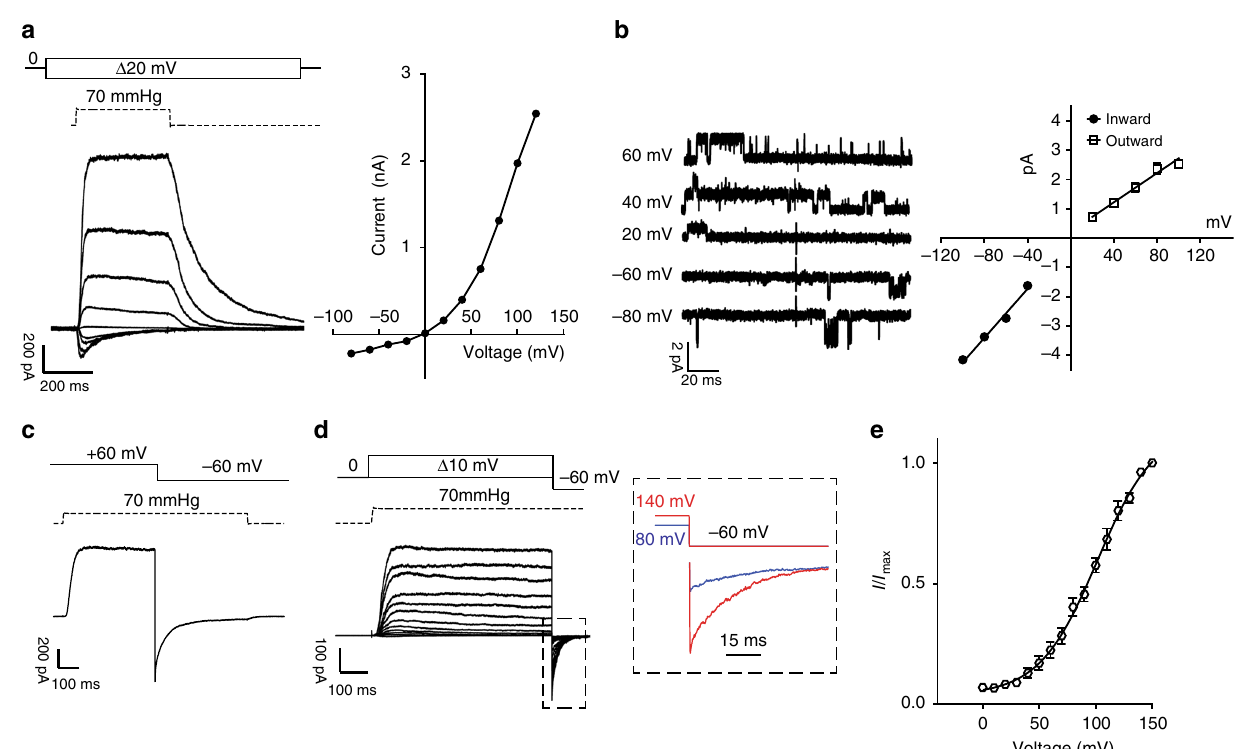
Fig. 1 Recti fi cation and voltage modulation of pressure-mediated PIEZO1 currents. a Left: example traces of currents elicited at a constant saturating pressure (70 mmHg) and at increasing voltages (in 20 mV steps from − 100 to 100 mV) in symmetrical Na + from excised outside-out patches overexpressing mPIEZO1 in N2a cells. Right: peak currents are plotted against voltage to show an I / V relationship. Note the outward rectifying behavior. b Left: single channel openings were recorded at negative and positive voltages to obtain the slope-conductance values. Right: linear regressions from individual patches were averaged and pooled. Inward slope conductance was signi fi cantly higher than outward slope conductance (41.3 ± 0.9 pS and 27.1 ± 1.2 pS, respectively, three cells. Student ’ s t -test P = 0.0006, d F = 4). c Example trace of instantaneous currents recorded upon switching voltage from + 60 to − 60 mV during the application of a 70 mmHg pressure stimulus (recti fi cation index 1.13 ± 0.06 ( n = 8)). Capacitance currents were digitally subtracted. d Current responses to a pressure stimulation of 70 mmHg during 300 ms voltage steps ranging from 0 to 150 mV, followed by a repolarization step to − 60 mV to obtain tail currents. The inset shows an expanded example of tail currents at − 60 mV originated from a pre-stimulation step at 80 (blue) and 140 mV (red) in the presence of 70 mmHg of pressure. e Tail currents from individual cells were normalized to their maximum and fi tted